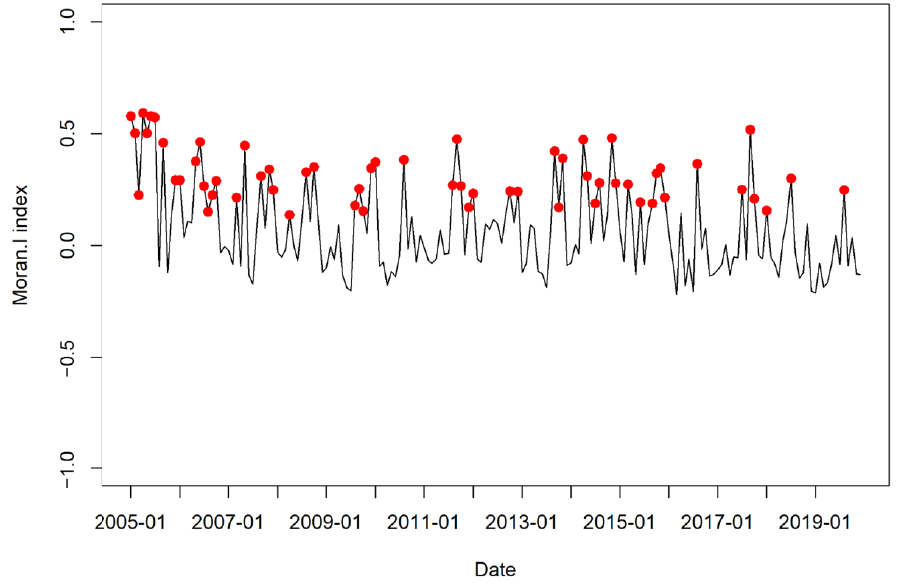
Figure A2. The Moran’s I index for 14 age groups from January 2005 to December 2019. Red points indicate there is significant between-groups correlation of residuals.